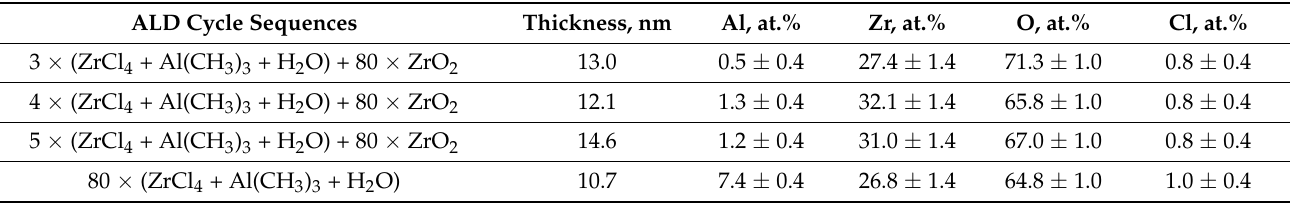
Table 2. ALD cycle sequence, together with thickness and elemental composition, measured by XRF for Zr x Al y O z -ZrO 2 films deposited on TiN substrates, applying first consecutive exposures of substrate surface to metal precursors without oxidizing steps between ZrCl 4 and Al(CH 3 ) 3 pulses in order to form Zr x Al y O z buffer layer prior to the main ZrO 2